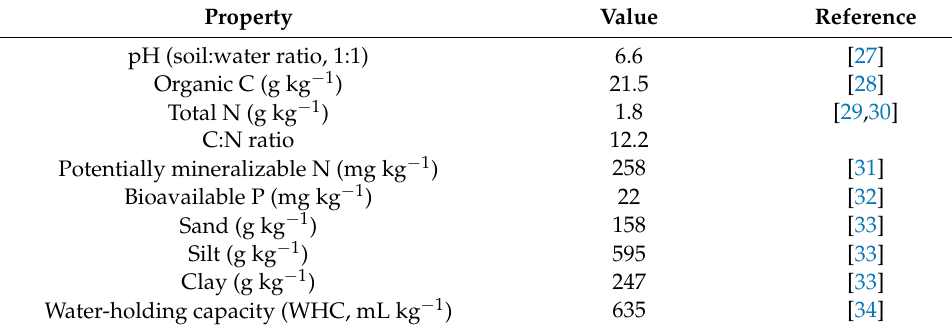
Table 1. Physicochemical properties of the soil